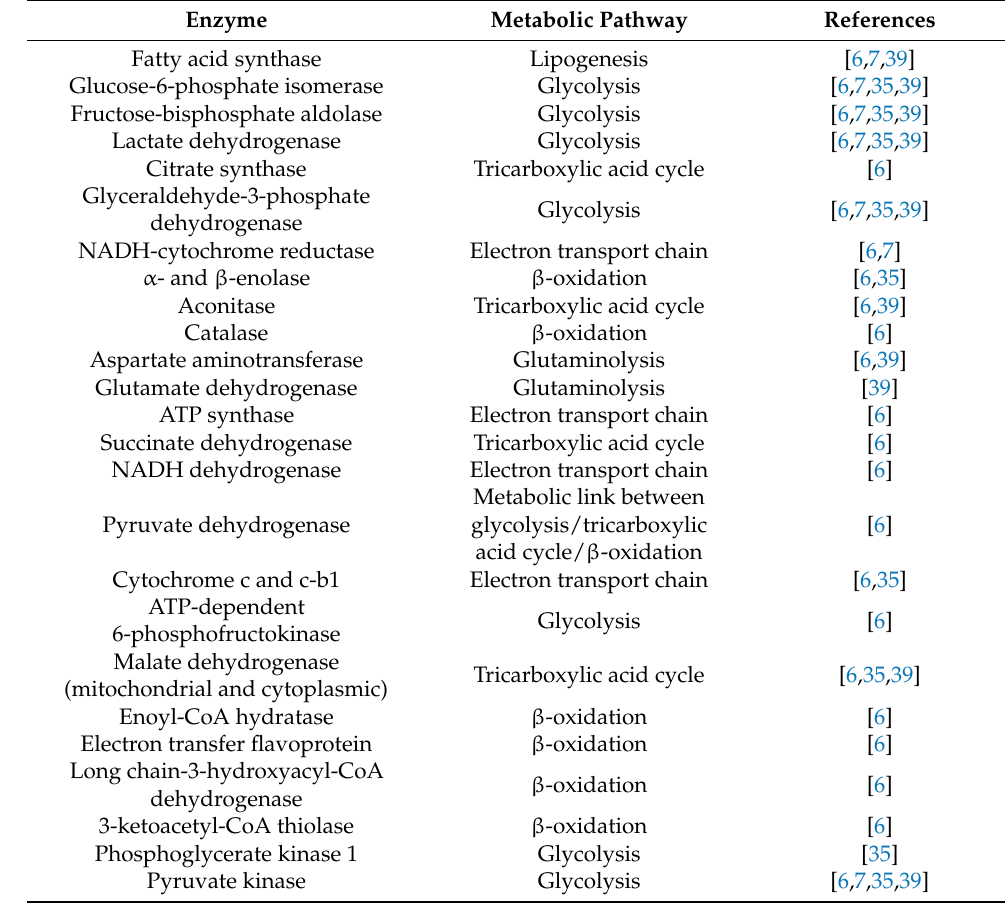
Table 1. Metabolic enzymes identified in neuroblastoma cell-derived